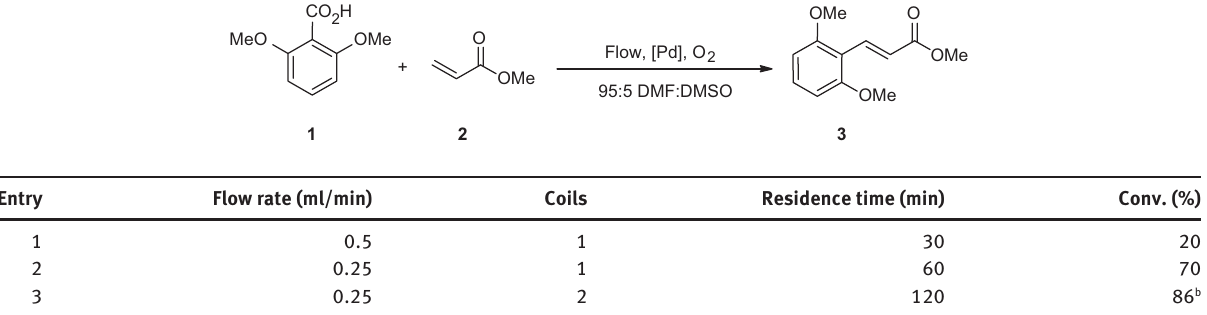
Table 2 Scale up of the reaction using continuous-flow processing. a